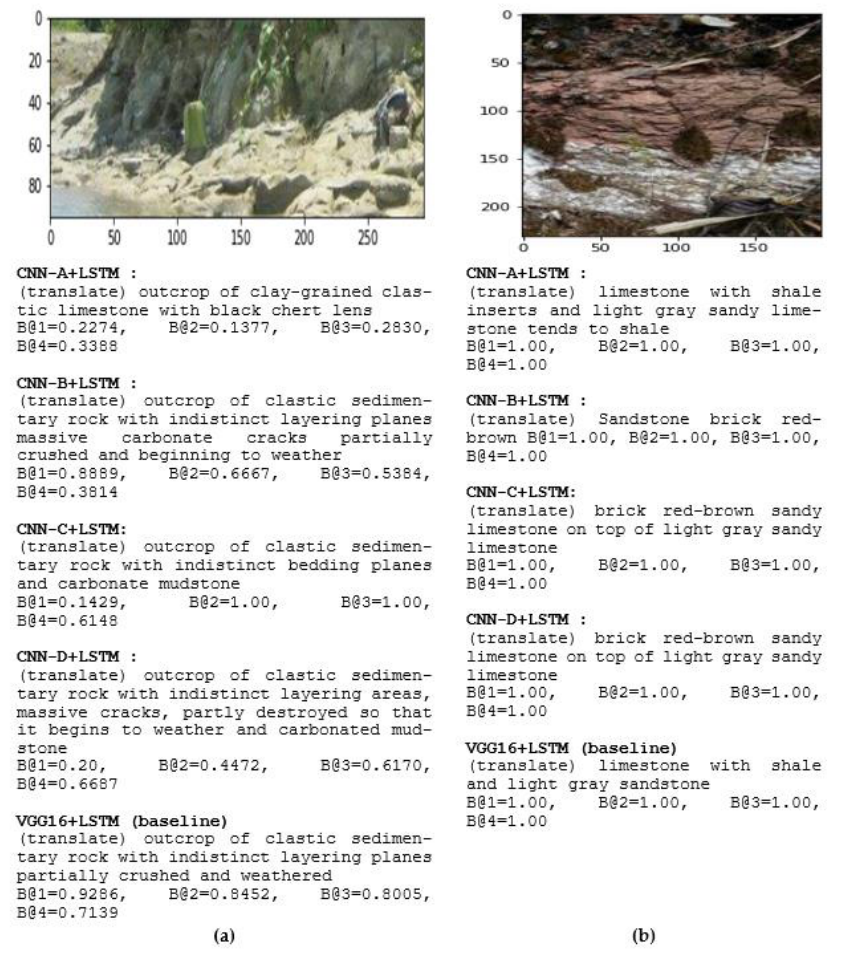
Figure 8. Examples of generated captions for geological captioning, translation into English. B@N is the BLEU score. ( a ) Sedimentary rock image; ( b ) limestone image on a different surface.